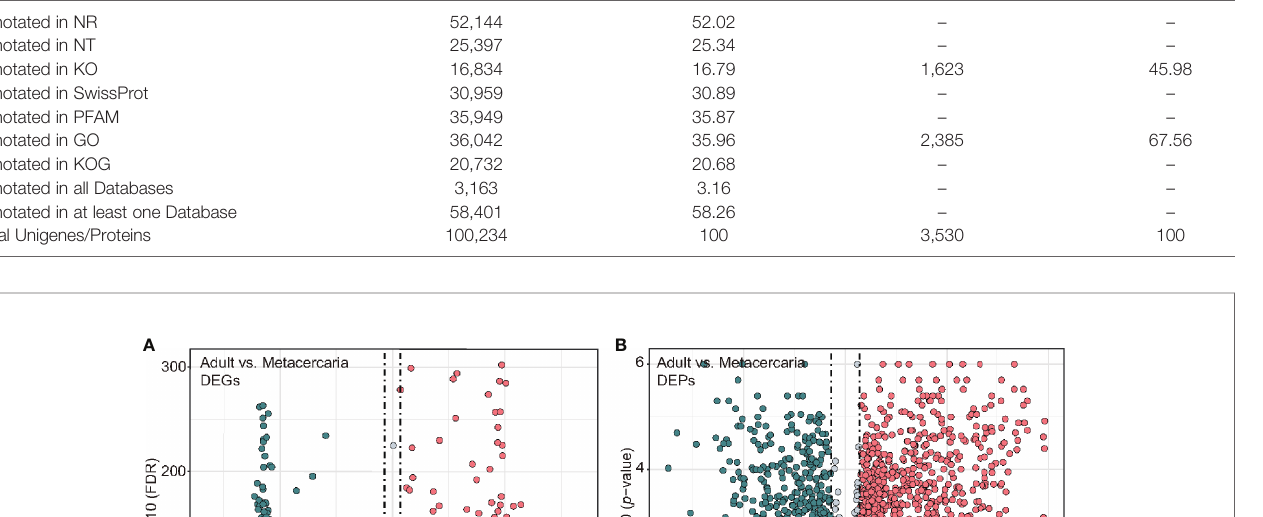
TABLE 1 | Bioinformatics annotation of transcriptome unigenes and proteome proteins. Bioinformatics annotations of unigenes